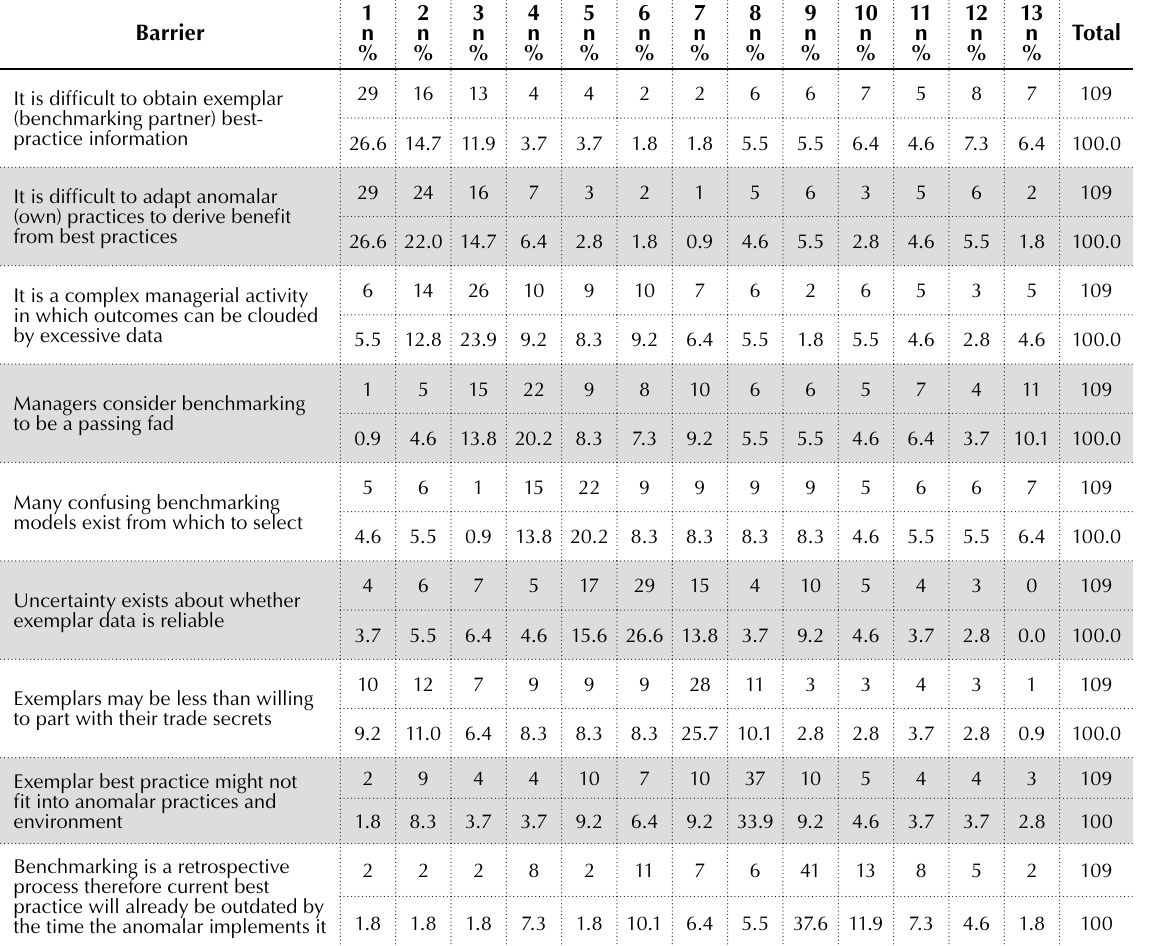
Table 1. Barriers to